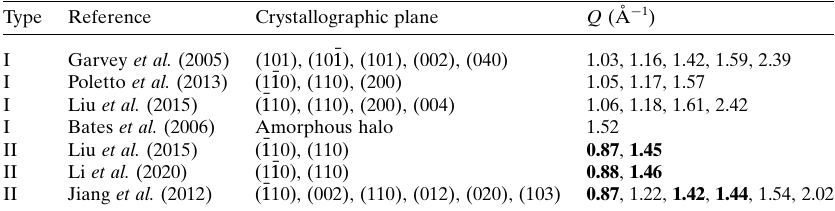
Table 1 Most common X-ray peak positions and corresponding crystallographic planes for native (Type I) and regenerated (Type II) cellulosic materials. The Bragg peaks analyzed in the present work are give in bold.